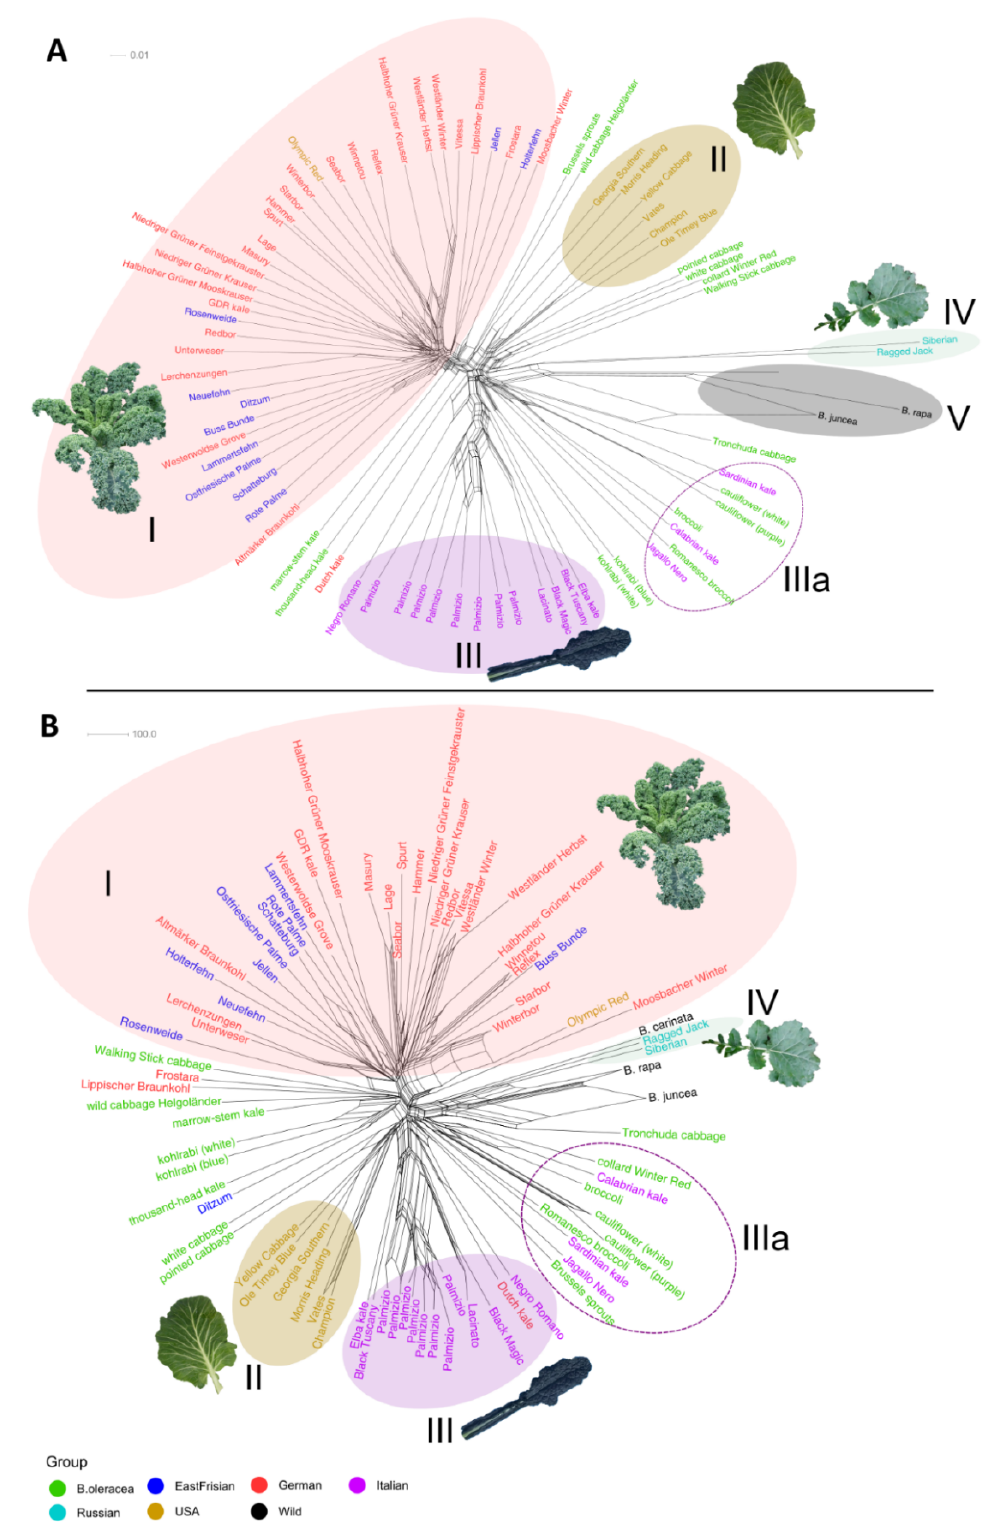
Figure 2. This is a wide figure. Figure 5. Neighbor-net showing genetic distances of different kale and cabbage varieties, based on ( A ) SNP data from the filtered dataset, and ( B ) using the SPLoSH information. Sample names are color coded according to their origin. Details on the observed clusters (Latin numbers) are explained in the